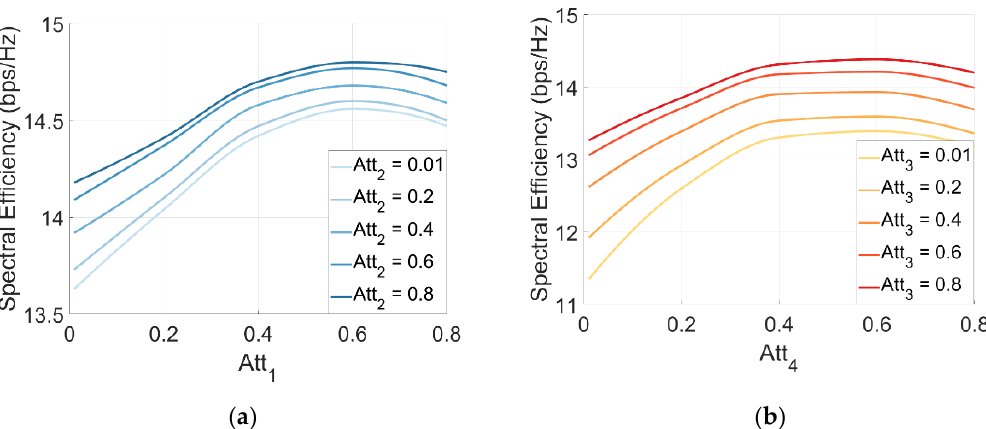
Figure 3. Spectral efficiency of a D-MIMO when the power balance is modulated with two balance factors. SINR is fixed to 15 dB. The i- MIMO systems that form the D-MIMO are the scenarios ( a ) A ( Att 1 ), B ( Att 2 ), C, D, E, and ( b ) C ( Att 3 ), D ( Att 4 ), E, F, G.